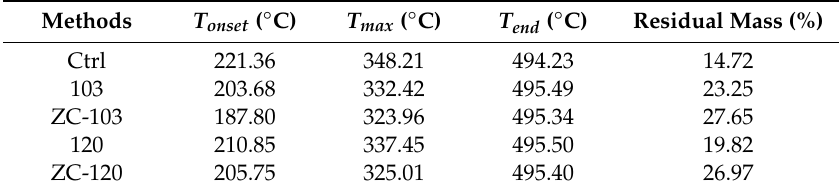
Table 2. Thermal properties of the 10% DM + 10% MA-treated samples in di ff erent groups. T onset : decomposition onset temperature; T max : maximum decomposition rate temperature; T end : decomposition termination